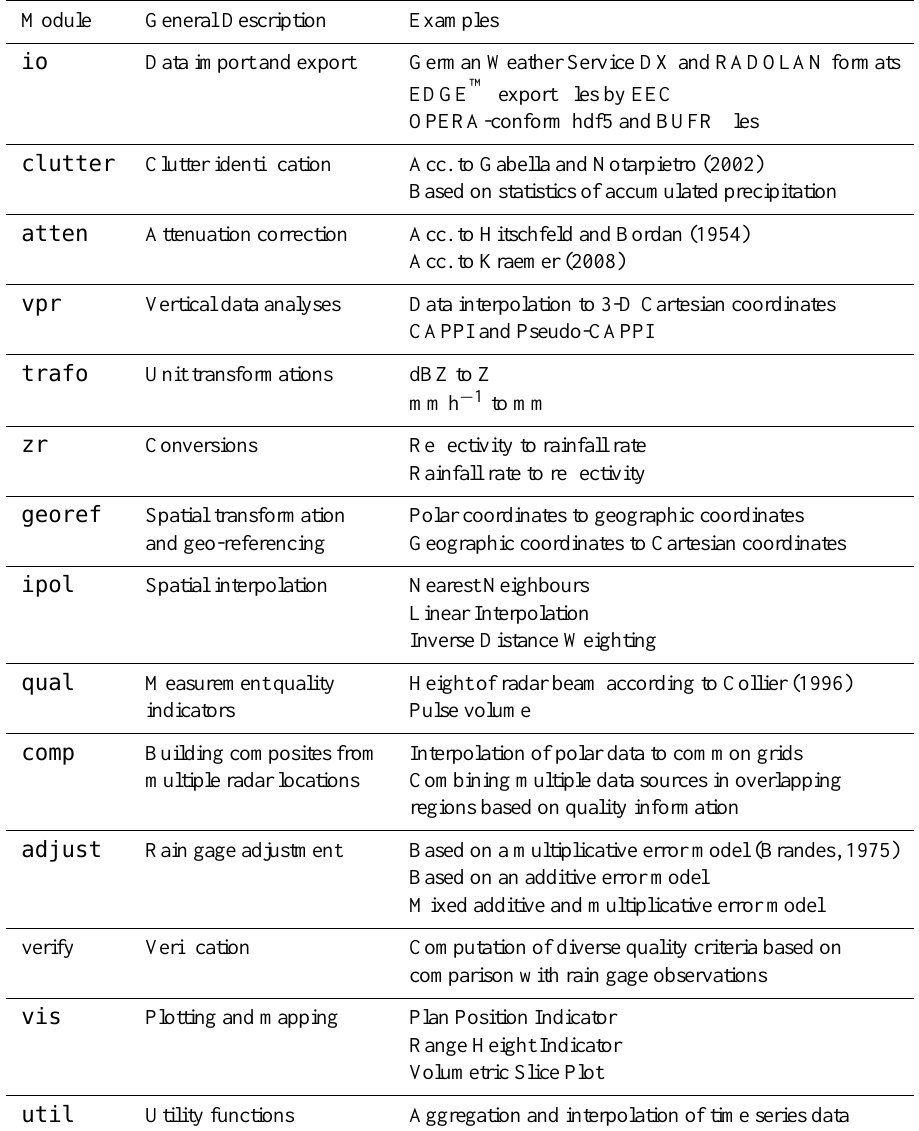
Table 1. Modules in wradlib